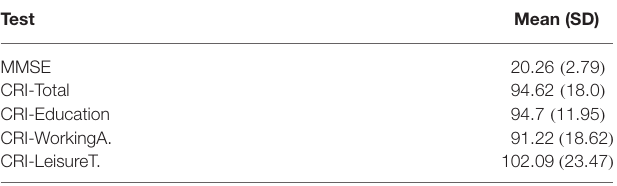
TABLE 2 | Psychometric evaluation of patients at